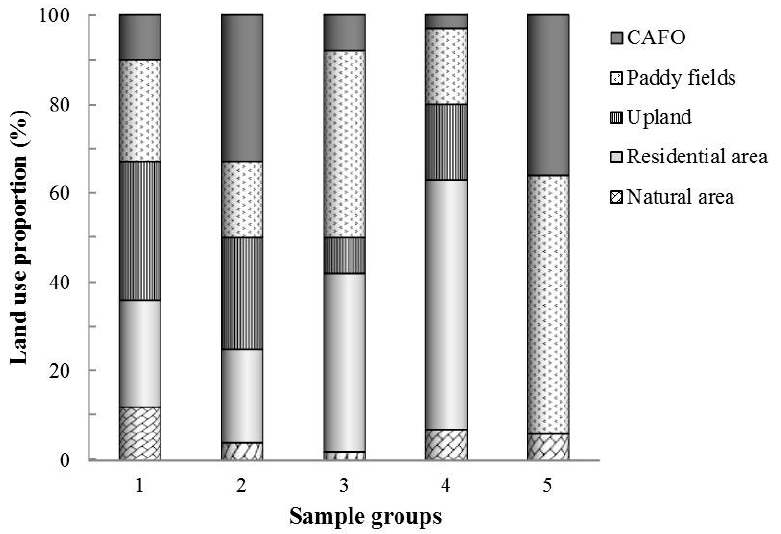
Figure 7. Proportions of land uses for the clustered groups. The land use patterns were assigned by analyzing a 50 m radius buffer.